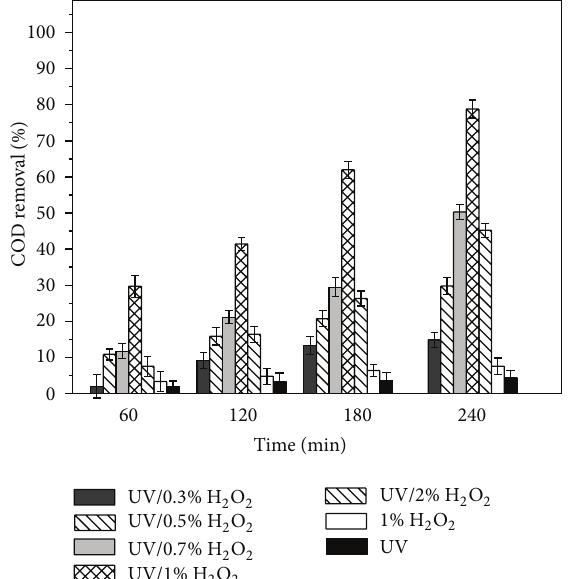
Figure 5: Effect of hydrogen peroxide dosage on COD removal. Experimental conditions: 25 ∘ C and initial pH of 10.